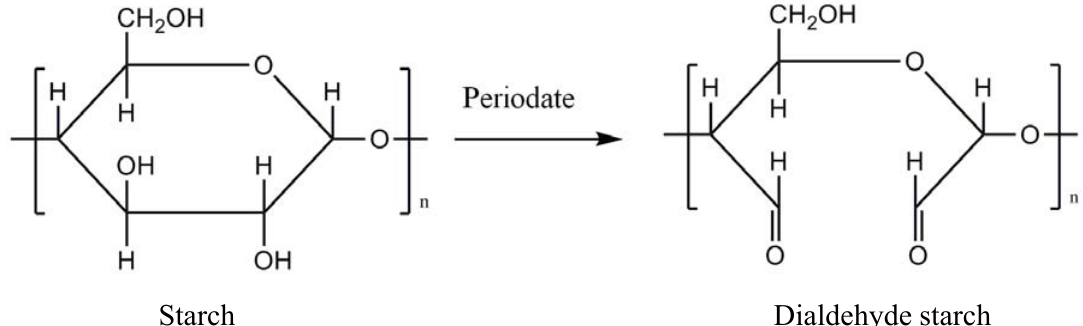
Dialdehyde starch